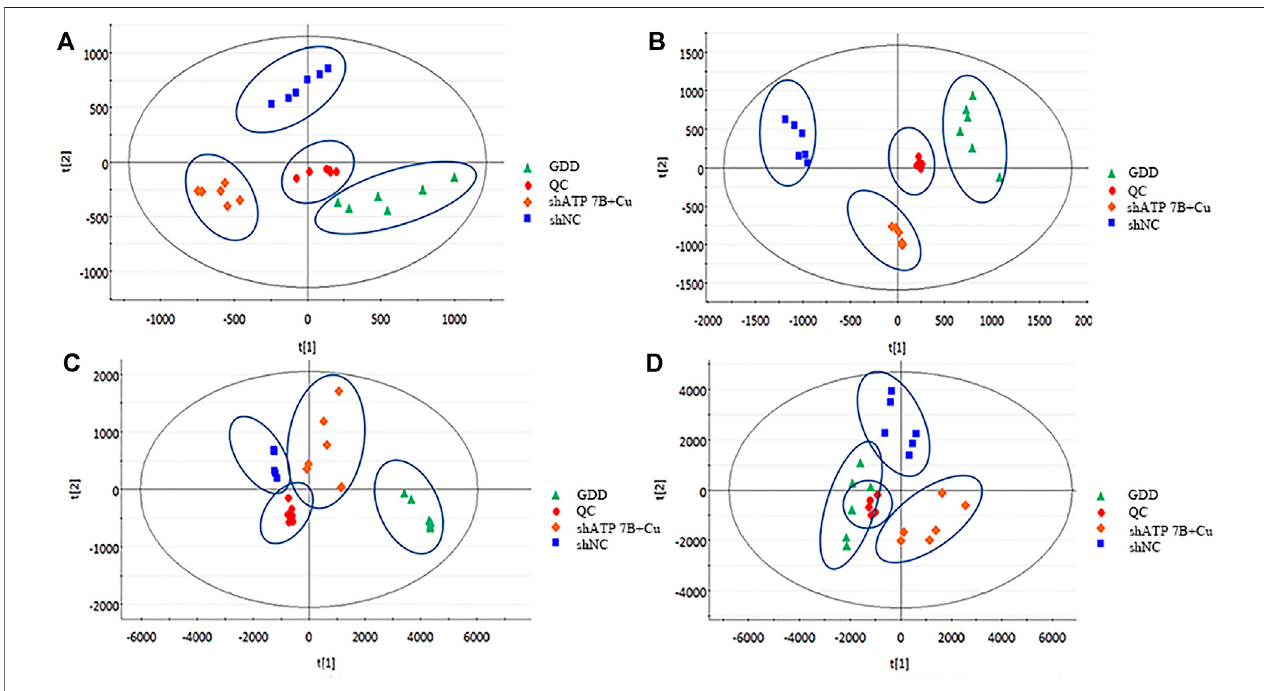
FIGURE 5 | PCA score diagram of cell samples in negative (A, C) and positive (B, D) ESI modes. (A, B) HILIC-Q-TOF/MS [ (A) : NEG-R 2 X = 83%, Q 2 = 53%; (B) : POS- R 2 X = 97%, Q 2 = 82%], (C, D) RPLC-Q-TOF/MS [ (C) : NEG-R 2 X = 99%, Q 2 = 97%; (D) : POS- R 2 X = 98%, Q 2 = 94%]. Each point represents a cell sample.